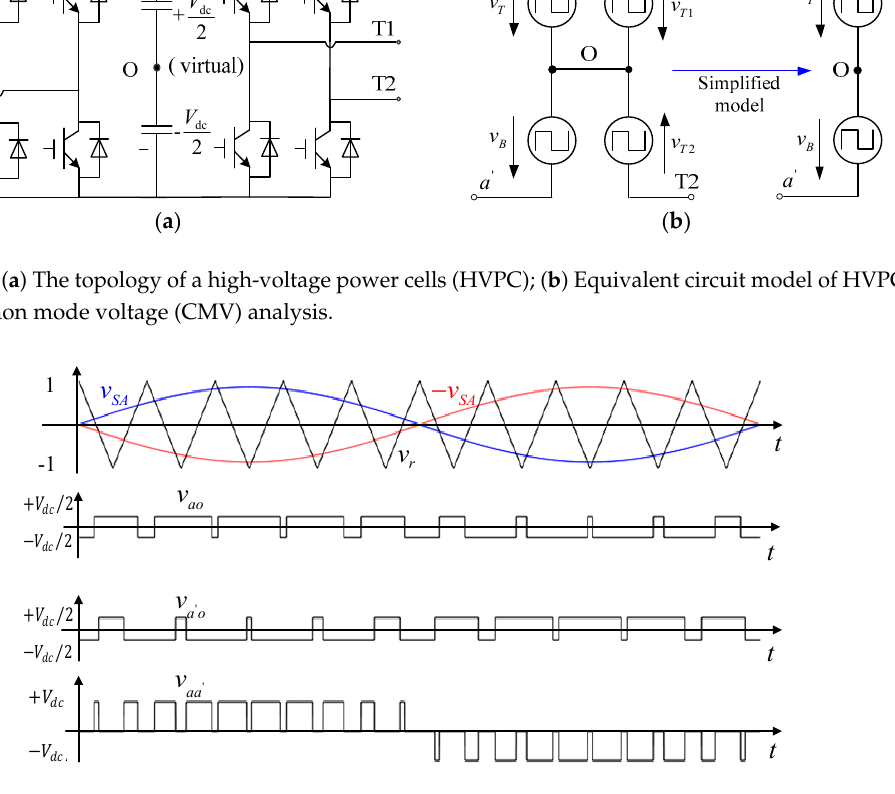
Figure 3. Unipolar sinusoidal pulse width modulation (SPWM) modulation strategy for an H-bridge.